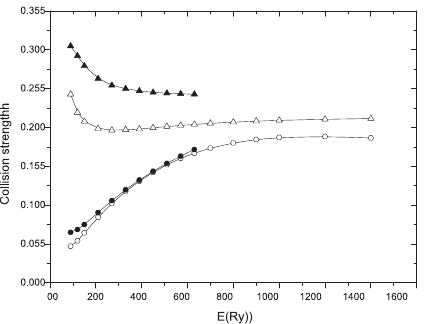
Fig. 3. The present collision strengths Fig. 4. The present collision strengths (open symbols) as a function of electron (open symbols) as a function of electron energy, compared to R-matrix DARC re- energy, compared to R-matrix DARC re- sults (solid symbols) for the two transi- sults (solid symbols) for the two transi- tions: 2 s 2 S 1 = 2 (cid:0) 2 p 2 P o (circles) and 2 s (cid:0) 3 s 2 S tions: 2 p 2 P o 1 = 2 1 = 2 (circles) and 2 p 3 = 2 (cid:0) 2 p 2 P o 2 S (triangles). (cid:0) 2 p 2 P o 2 P o 1 = 2 3 = 2 1 = 2 3 = 2